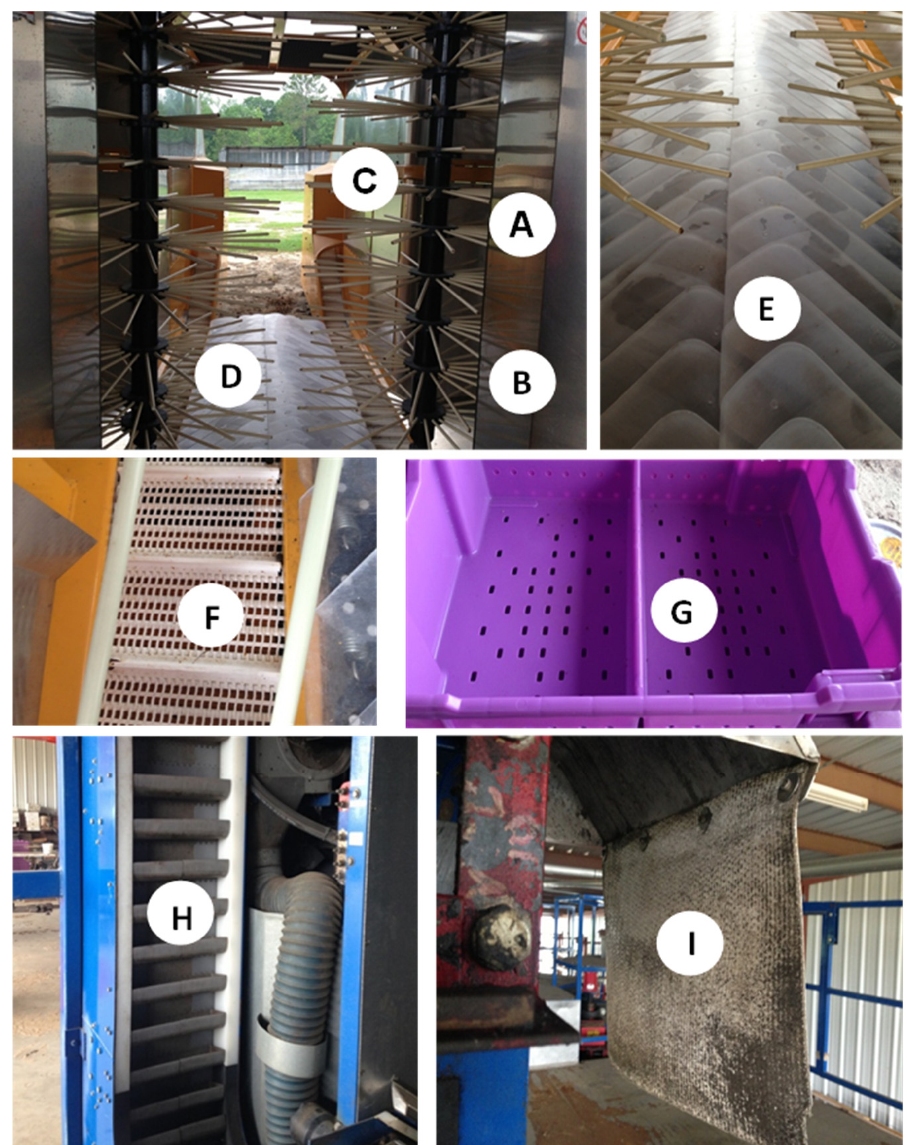
Figure 1. Photographs of blueberry mechanical harvester surfaces for microbial sampling: upper tunnel sidewall ( A ), lower sidewall ( B ), upper shaking rods ( C ), lower shaking rods ( D ), catcher plates ( E ), horizontal conveyor belt ( F ), berry lug ( G ), vertical conveyor belt ( H ), and filling flap ( I ). The latter two surfaces are found only on top-loader harvesters. Table 1. Composition of blueberry mechanical harvester fruit contact surfaces assessed in this study.